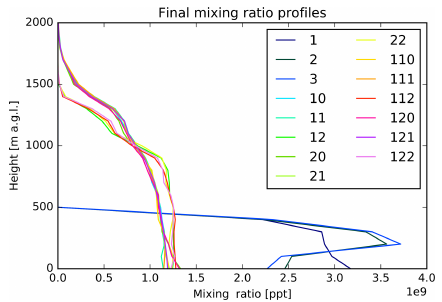
Figure D1. Final mixing ratio profiles in the surface tracers test released over the sea. The legend shows the numerical value of the TURB_OPTION parameter